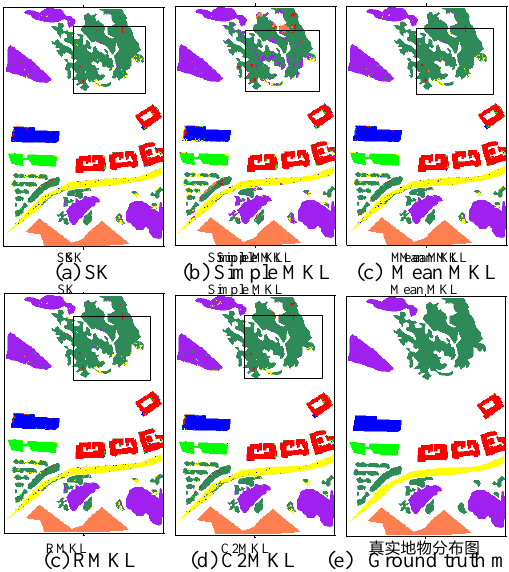
Figure 9. Classification maps of different methods on Bayview Park data set.